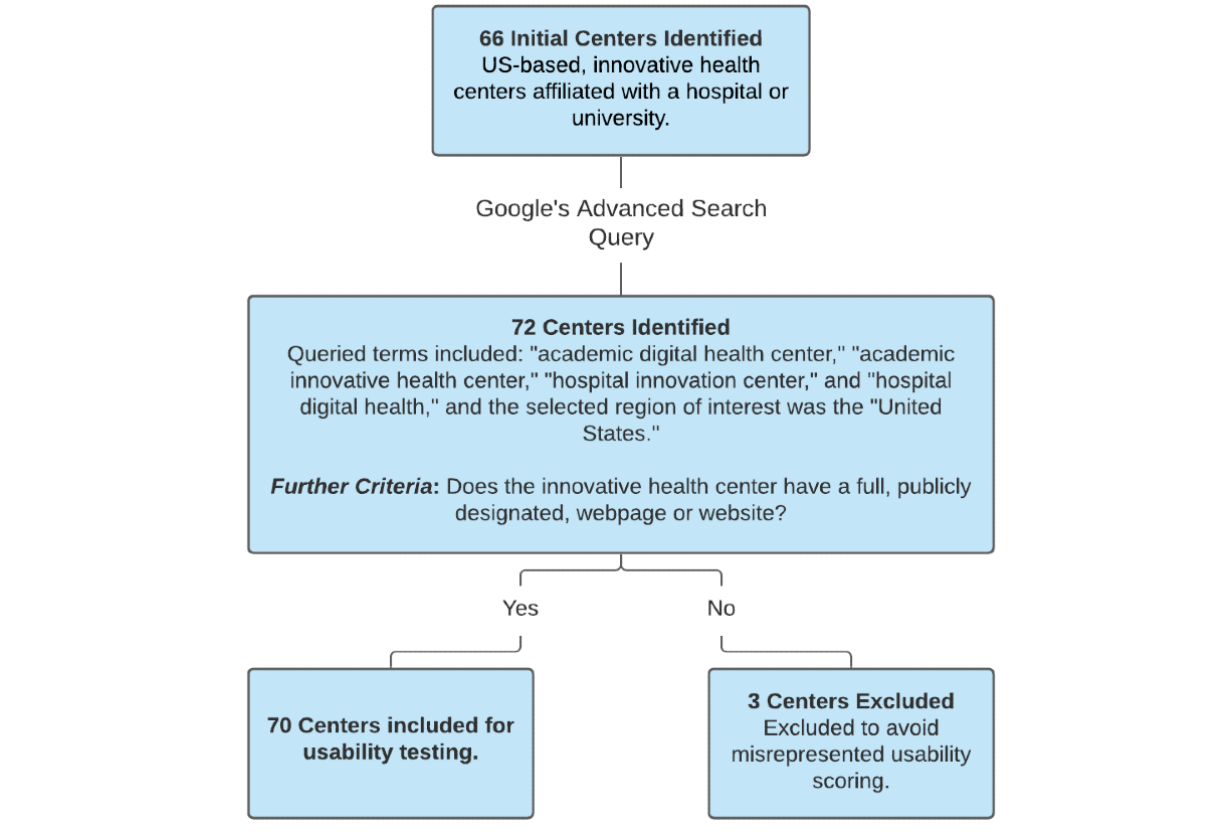
Figure 1. Sample selection criteria for digital health center